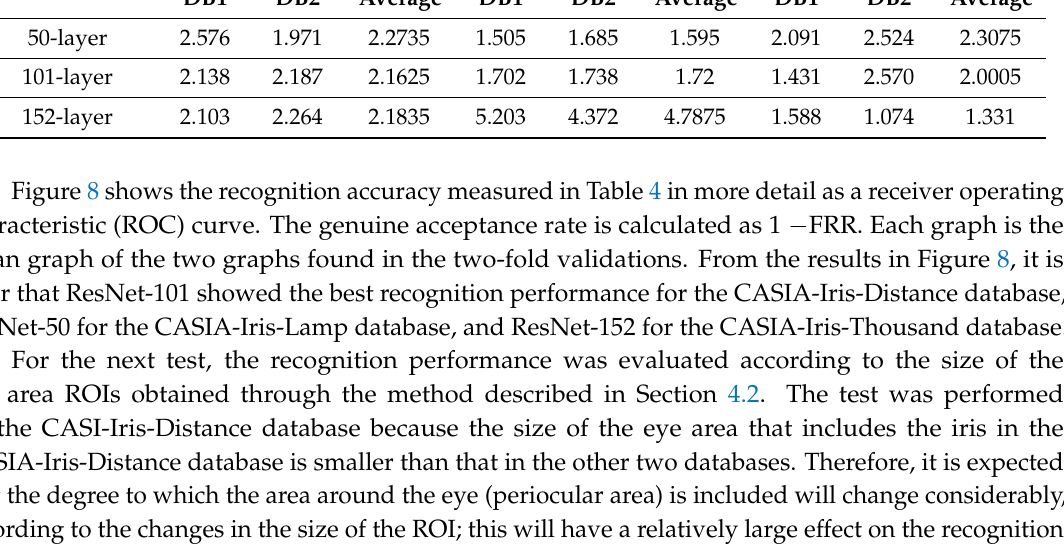
Table 4. Comparative EERs with each dataset by various ResNet architectures (unit: %). ResNet